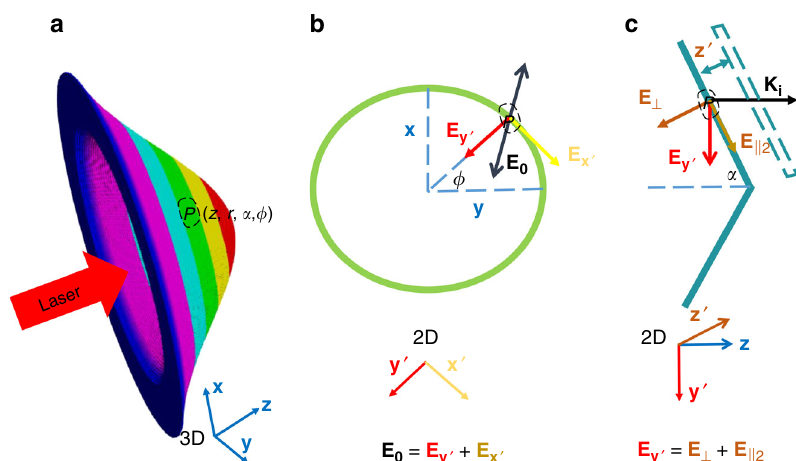
Fig. 4 The perpendicular component of the transverse electric fi eld. For a dented target, the component E ? of the driving electric fi eld, which is perpendicular to the local surface, will oscillate the plasma surface. At a position P ð z ; r ; α ; ϕ Þ on the target, the perpendicular component E ? can be calculated by two steps. (1) First the electric fi eld vector E E ð r Þ sin ð ω t (cid:2) k z þ ϕ Þ y 0 and E 0 L L